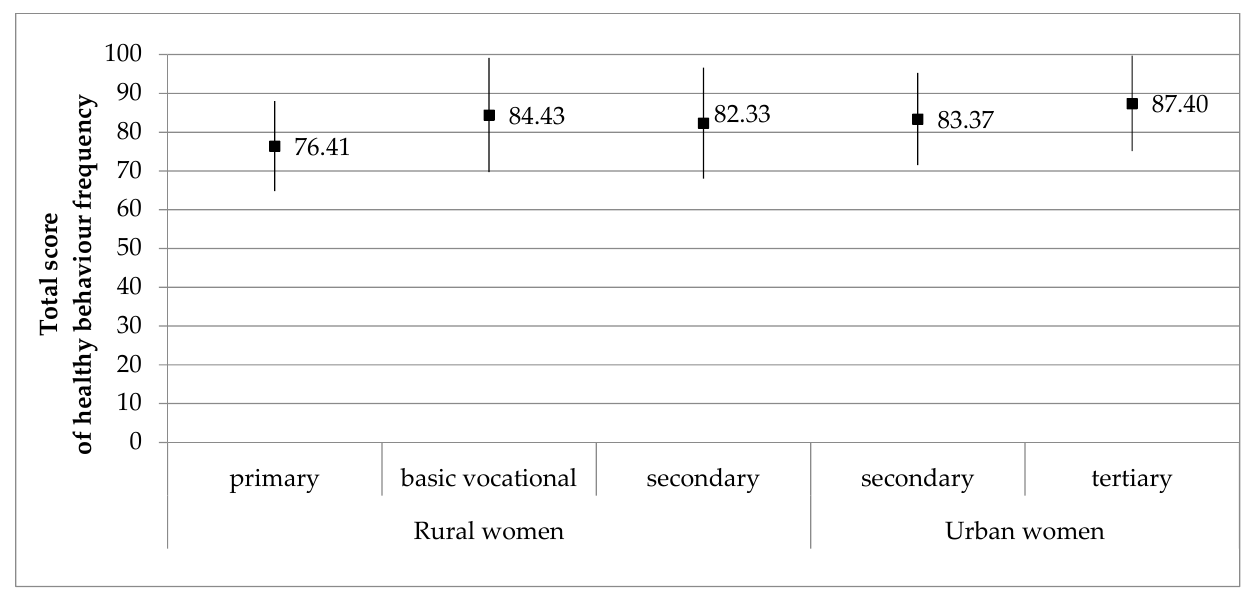
group is large and the other groups are very small. p for significant differences or correlation is in bold.